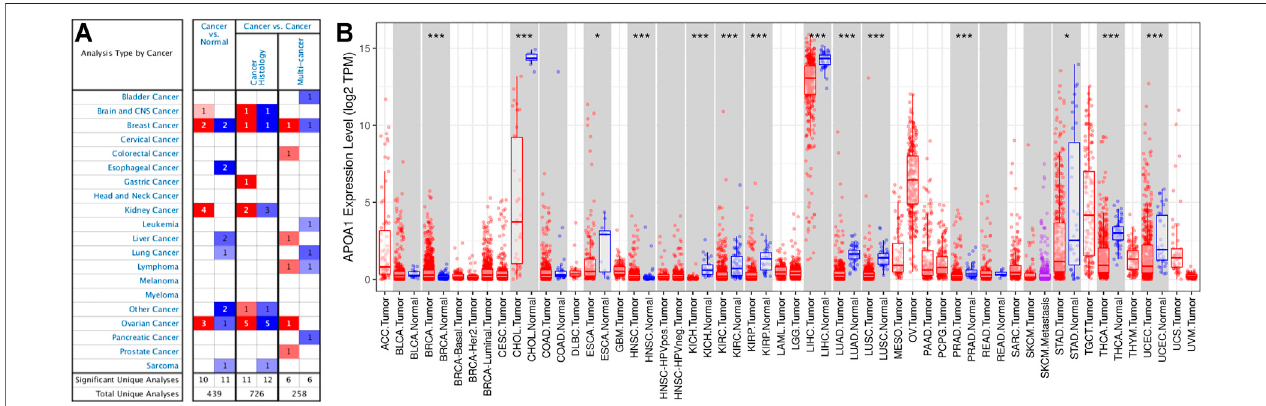
FIGURE 1 | Expression of APOA-1 in human cancers. (A) Disease summary for APOA-1. Red: high expression, blue: low expression. The threshold was set as follows: p -value < 0.05, fold change: 2, gene rank: 10%; (B) Bar plot of APOA-1 expression pro fi le in various cancers and normal specimens. All data were derived from the Oncomine database and the Tumor IMune Estimation Resource (TIMER).